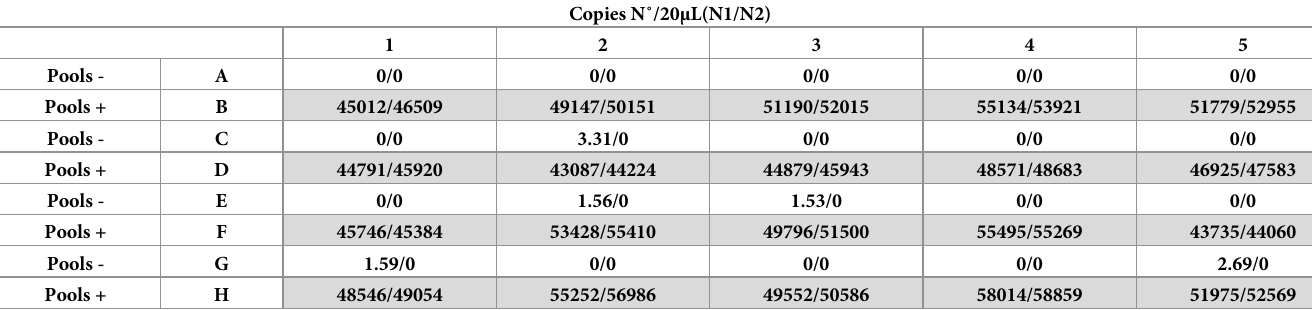
Table 4. Seeding method in PCR plate and results.